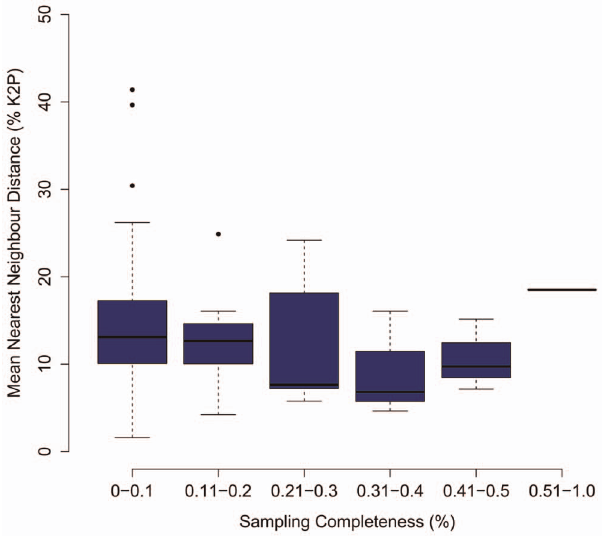
Figure 5. The relationship between COI distance and sampling completeness within genera. Mean nearest neighbour distance (% K2P) at COI plotted against sampling completeness (%) of each genus of marine mollusc with $ 2 species (N =50). The ANOVA was insignificant (P=0.77). Morphospecies lacking a generic identification were excluded from analysis.